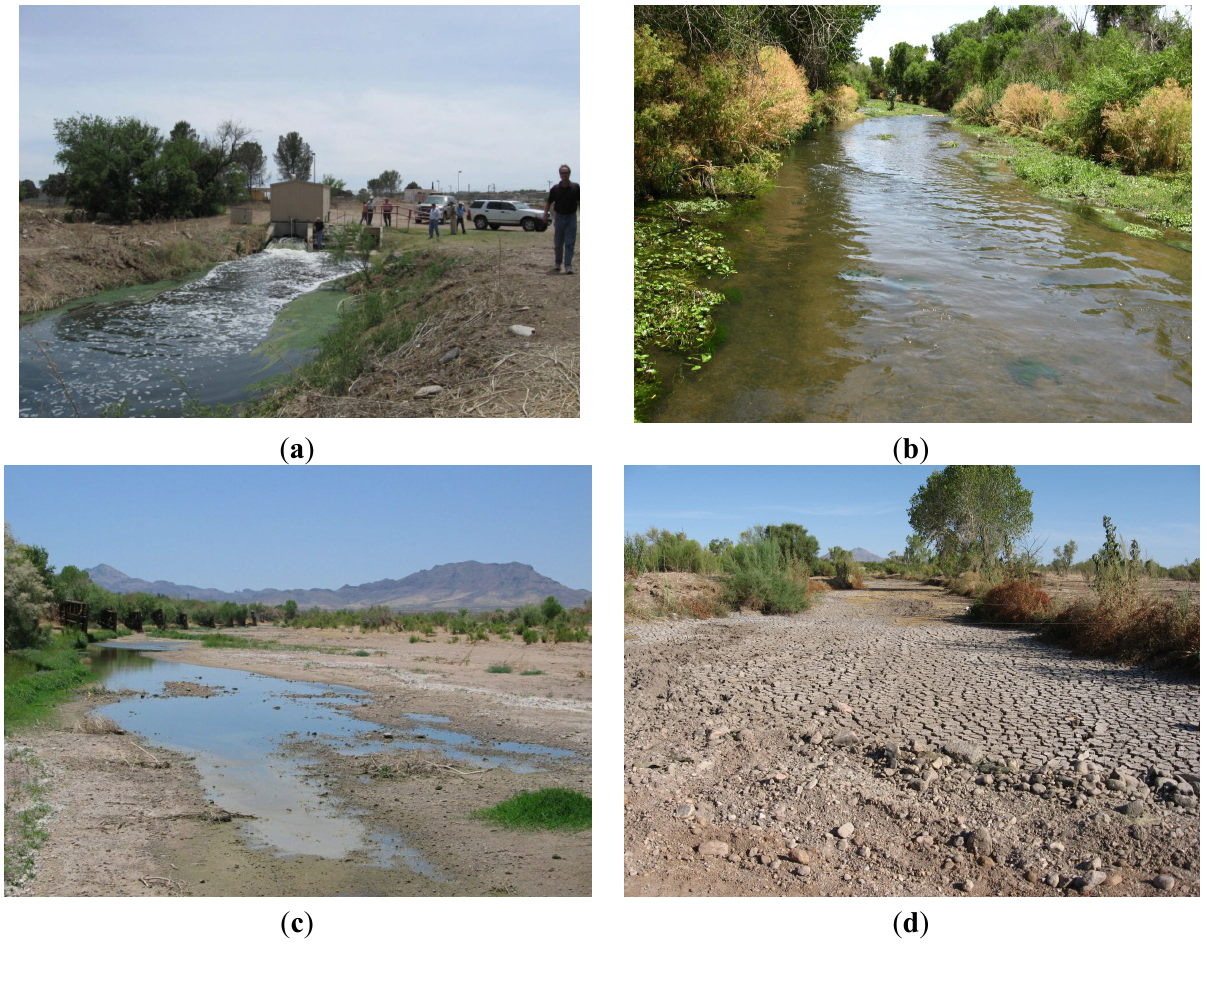
Figure 3. Photographs of reaches of the Santa Cruz River moving away from the NIWTP, where ( a ) water is being discharged at the outfall of the NIWTP (Photo from Tosline [26]); ( b ) the river is flowing northward; ( c ) the river is drying out at Amado; and ( d ) the dry bed north of Amado (Photos b–d by Sam